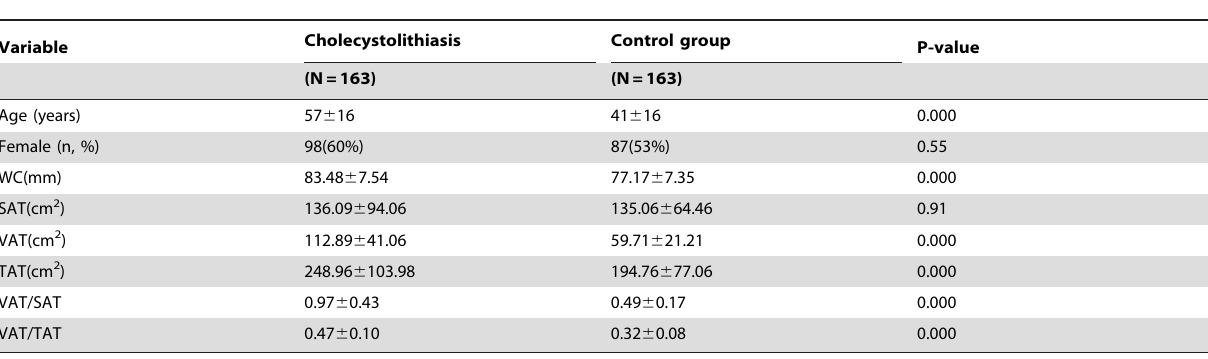
Table 1. Subject characteristics and adipose tissue